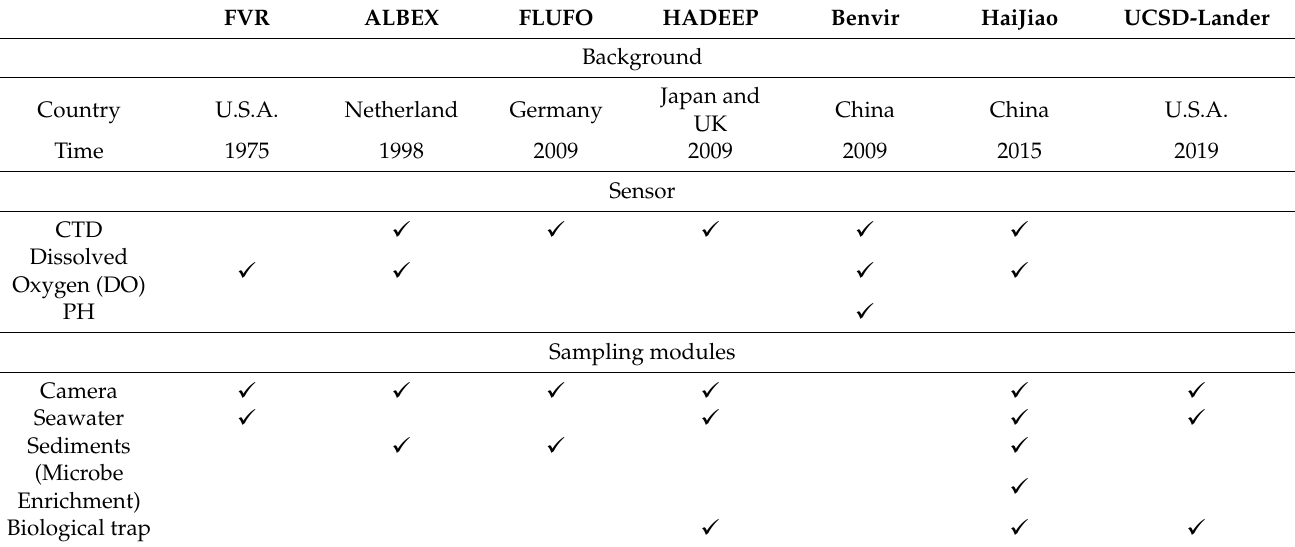
Table 1. Summary of typical benthic landers used in in situ studies of deep-sea ecology, resources and environments.